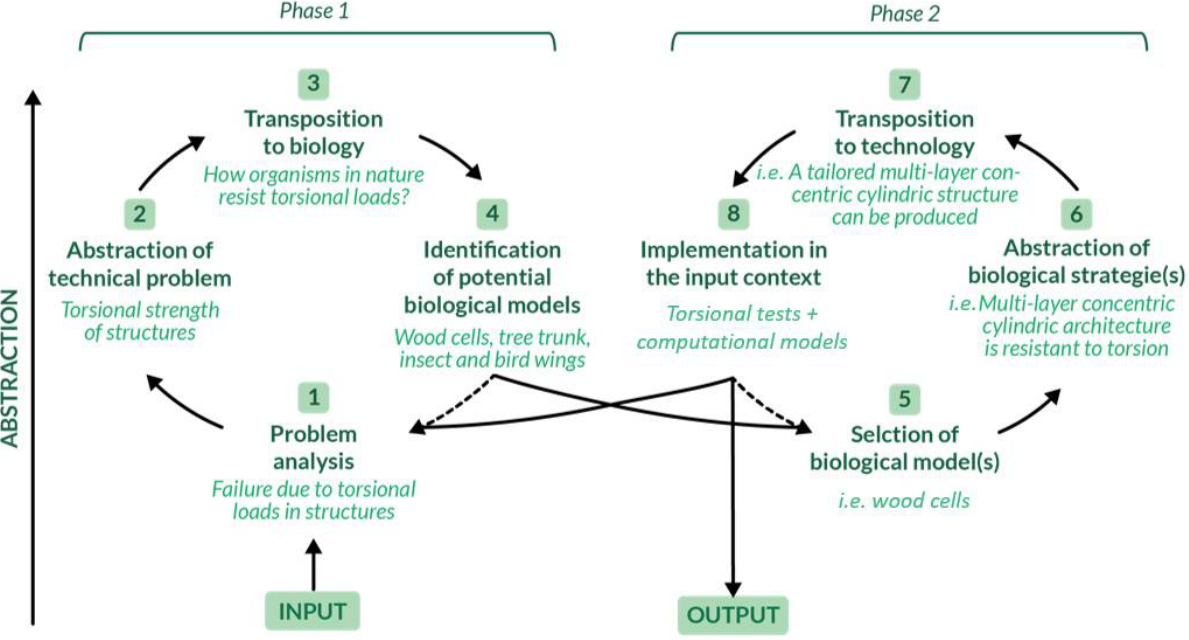
Figure 4. A schematization of the process model of biomimetics to address the torsional issue is presented. It is divided into two phases and eight steps: each of these steps takes advantage from specific tools such as problem analysis, abstraction, transposition, etc. [99,108]. Adapted with permission from [99].